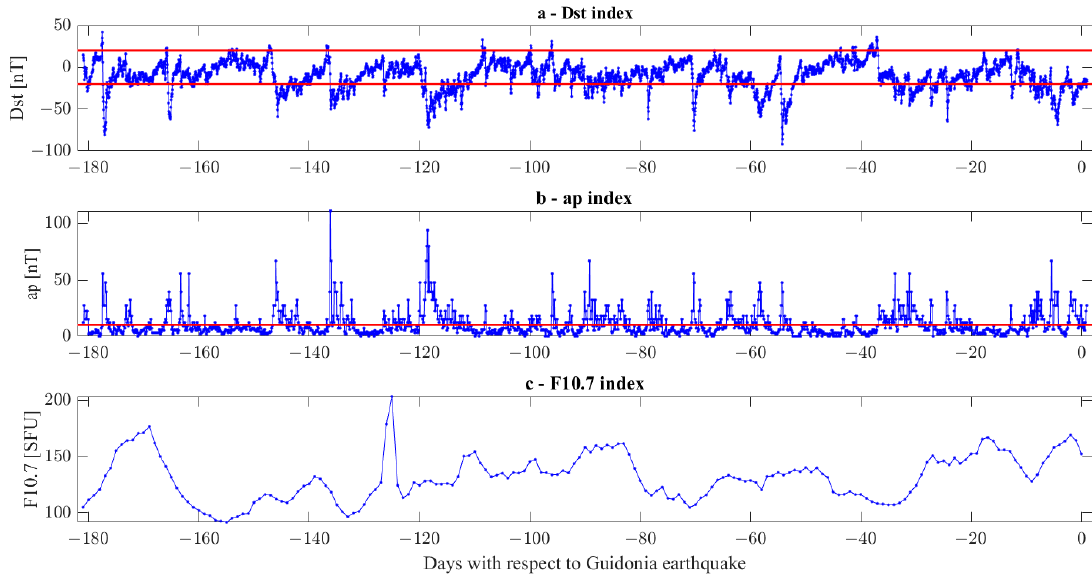
Figure 8. Geomagnetic indexes Dst ( a ), ap ( b ) and solar activity F10.7 index ( c ) in the six months before the ML = 3.3 Guidonia 1 January 2023 earthquake. Red lines show the thresholds used in the automatic codes to distinguish quiet or disturbed conditions (|Dst| > 20 nT or ap > 10 nT).